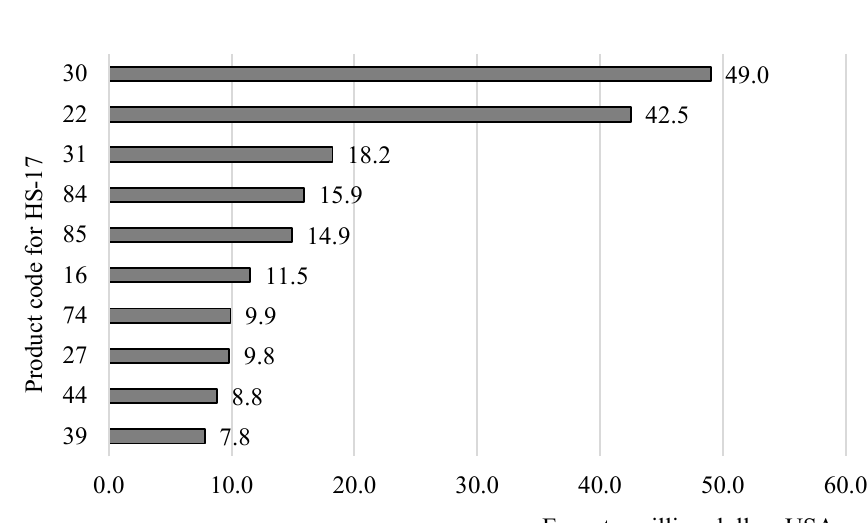
Fig. 3. Top 10 goods exported from Latvia to Ukraine in 2021 (United Nations, 2022).